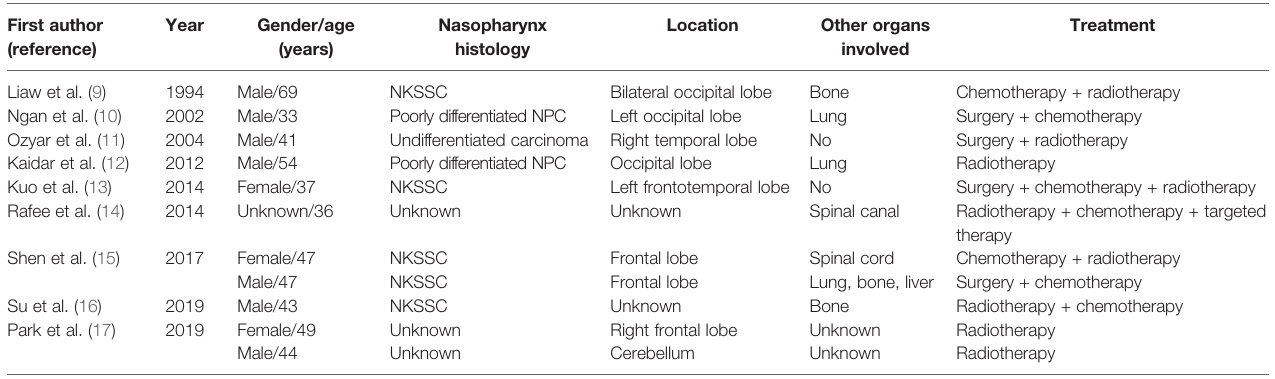
TABLE 1 | Summary of previous studies reporting brain metastases from